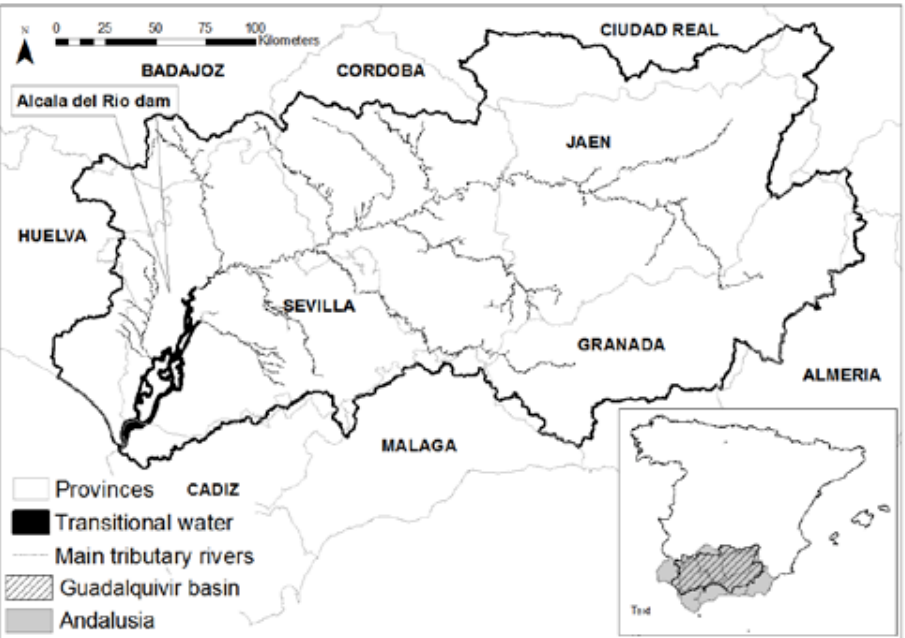
Figure 1. Guadalquivir River